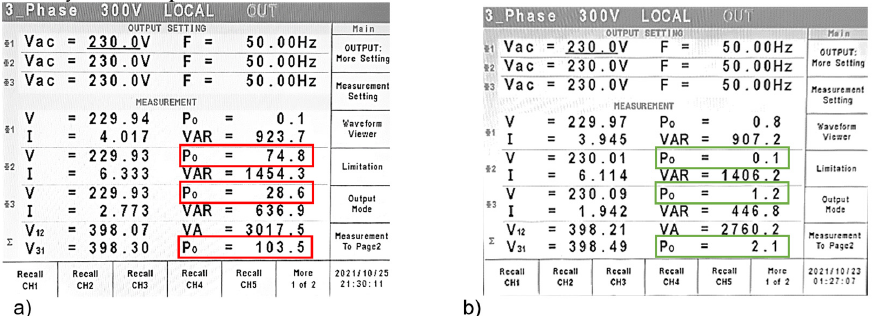
Figure 14. Programmable AC source measurements (at PCC point) without ( a ) and with ( b ) three individual one-phase PLL synchronization modules.